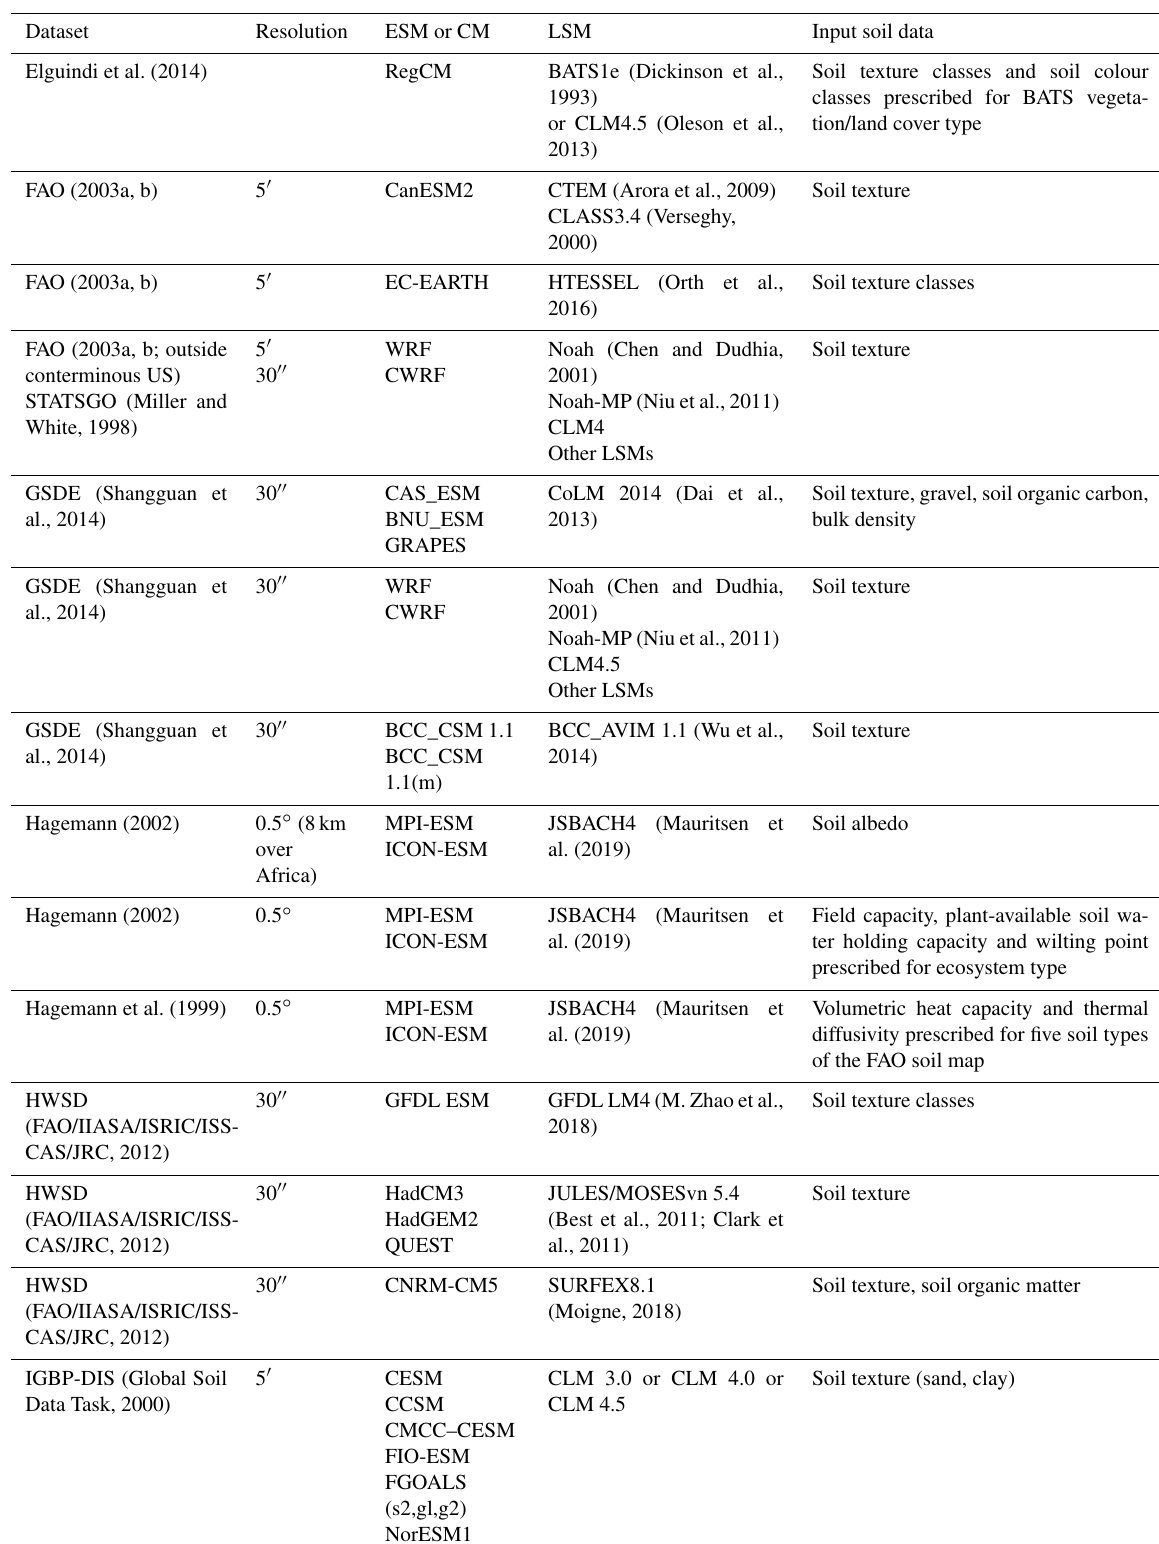
Table 1. Lists of the soil dataset used by land surface models (LSMs) of Earth system models (ESMs) or climate models (CMs).